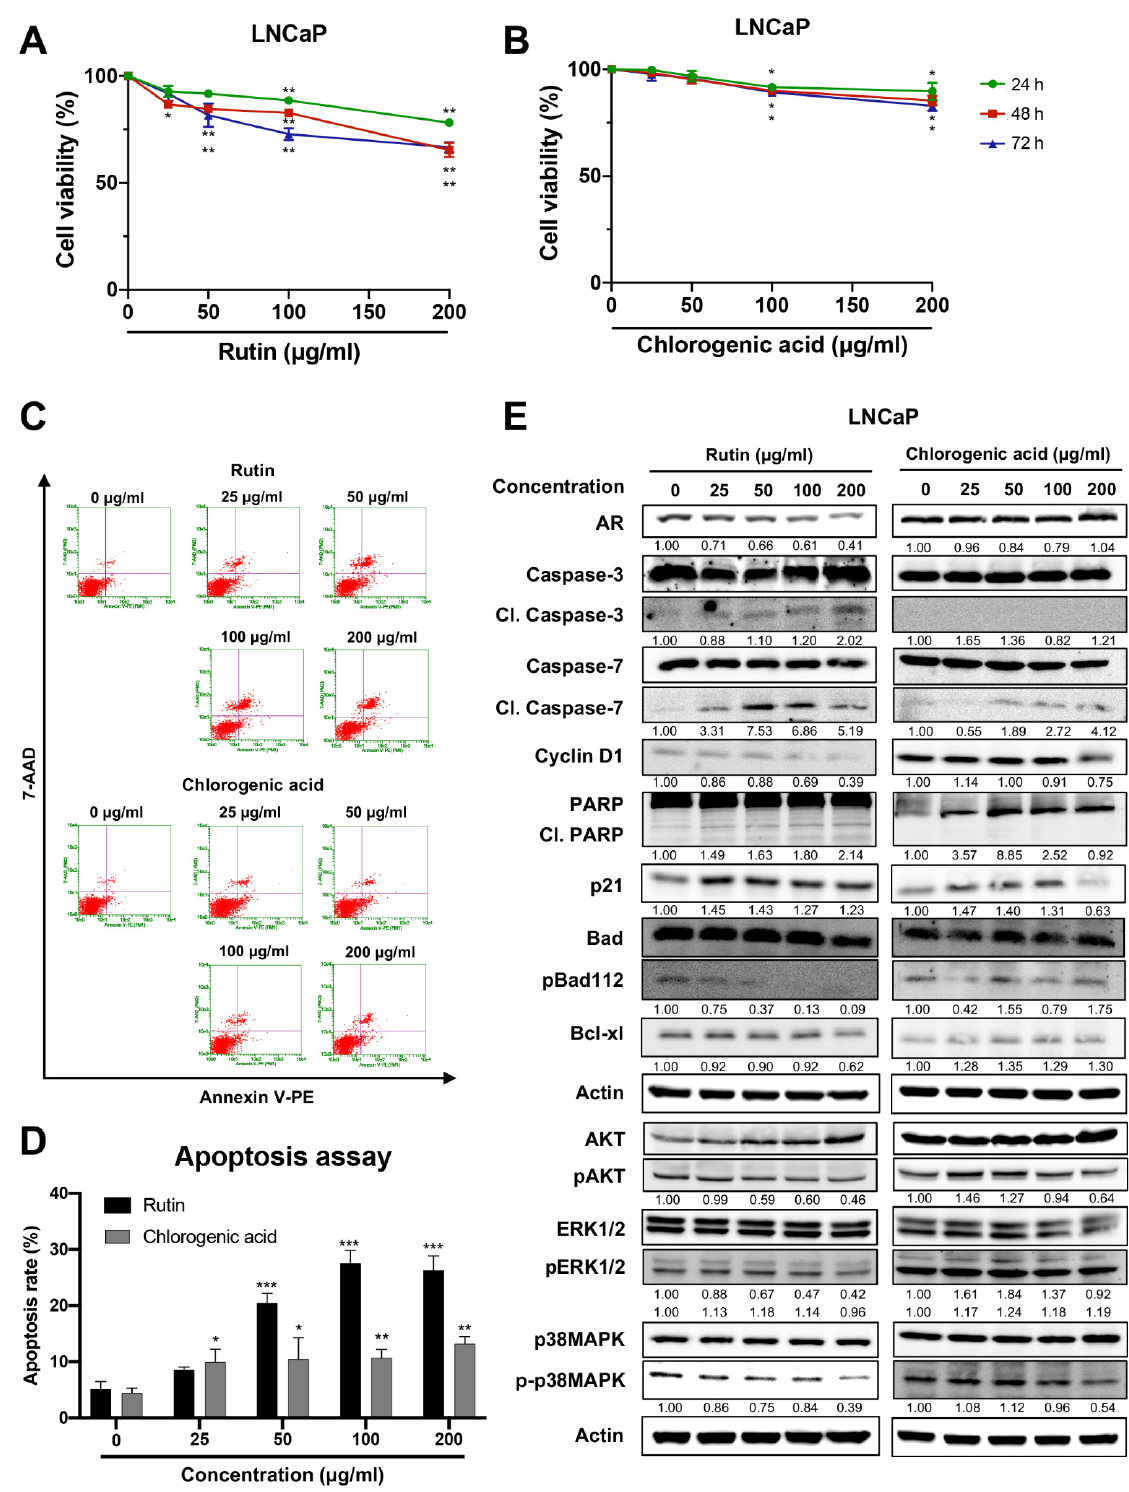
Figure 5. Effect of rutin and chlorogenic acid on apoptosis induction in LNCaP cells. The cytotoxic effect of rutin ( A ) and chlorogenic acid ( B ) on LNCaP cells was determined at 24, 48, and 72 h. Graphic dot plots of apoptotic cells ( C ) were generated and the percentage of total apoptotic cells ( D ) for LNCaP cells was quantitated in bar graphs. Immunoblotting analysis to show cell proliferation and apoptosis-related proteins in LNCaP cells in response to rutin and chlorogenic acid ( E ). Whole un-cropped images see Figure S5. Data represent mean ± SD. * p < 0.05, ** p < 0.01, and *** p < 0.001 vs.